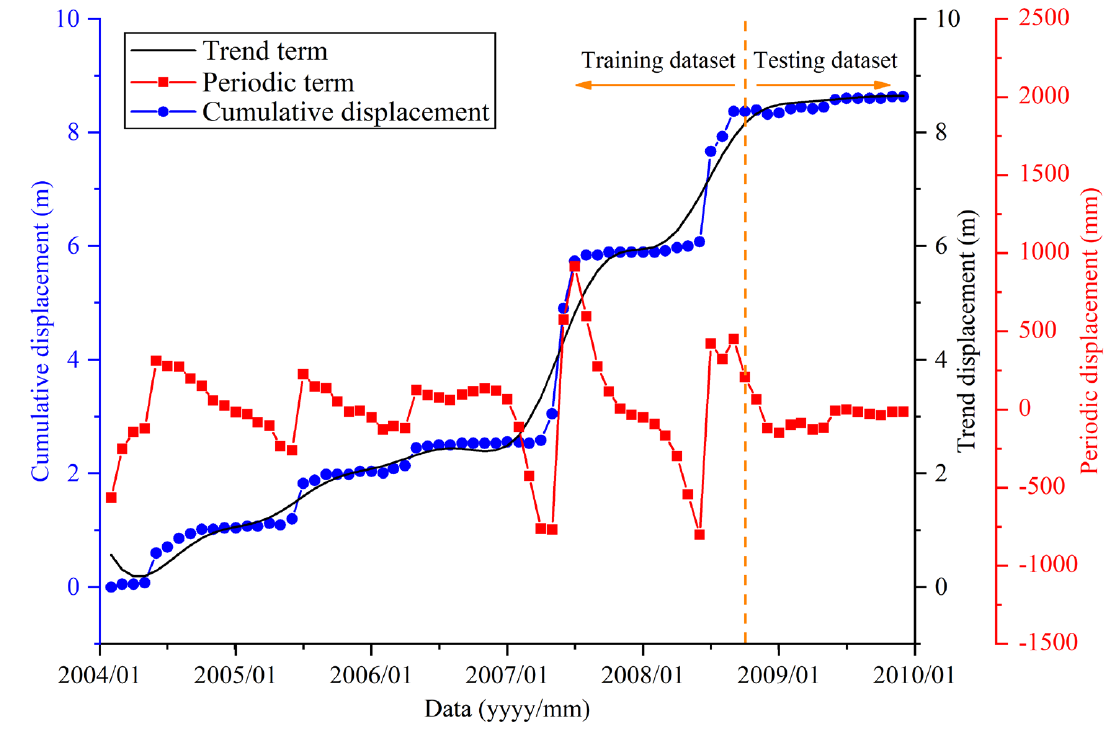
Figure 10. Periodic and trend displacement at site G1 obtained through CEEMD.